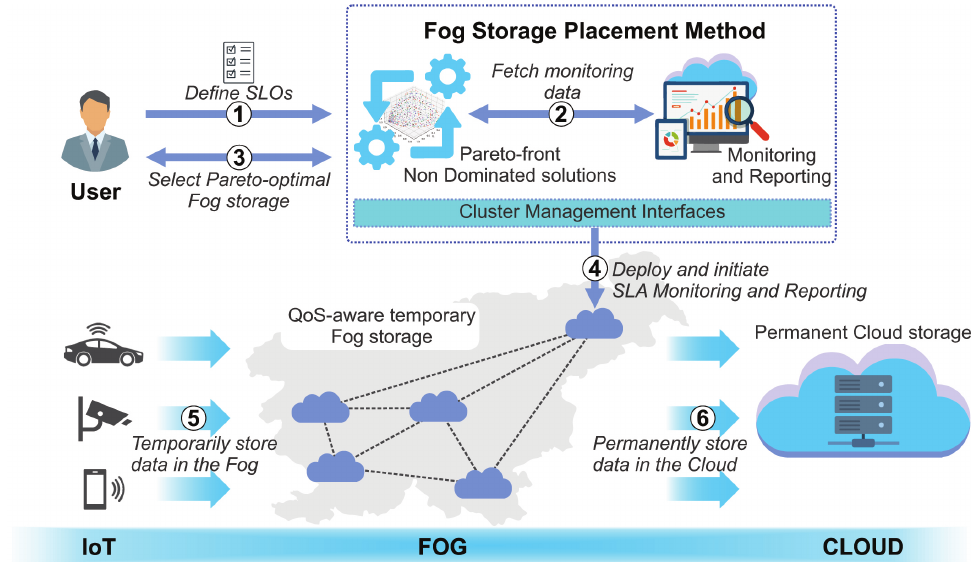
Figure 1. Introducing dynamic Fog Storage